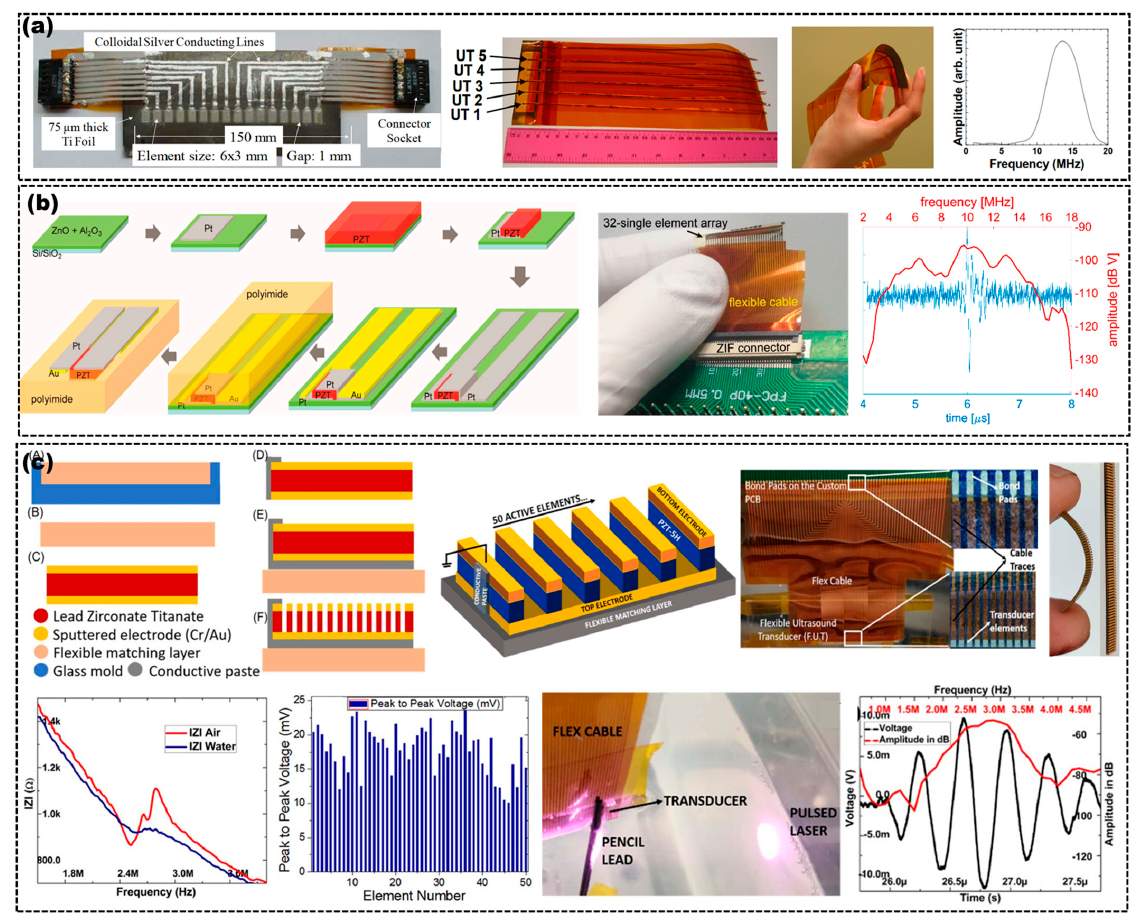
Figure 4. ( a ) Top view of a 1 − D linear flexible US transducer based on PZT ( left ), optical images ( left second ), flexibility test ( left third ) and frequency spectrum ( right ) of a flexible PZT/PZT 5 − element 1 − D array. Adapted from [36,38]. ( b ) Fabrication process of a single element ( left ), optical image ( middle ) and performance ( right ) of a 32 − element 1 − D array based on PZT. Adapted from [16]. ( c ) Fabrication process ( top left ), 3D schematic ( top second ), optical images ( top right ) and performances ( bottom left, second and right ) of a flexible 1 − D array, a flexible 1 − D array with flexible PCB ( top third ) and experimental setup used for the obtained PA signals from pencil lead ( bottom third ). Adapted from [55].